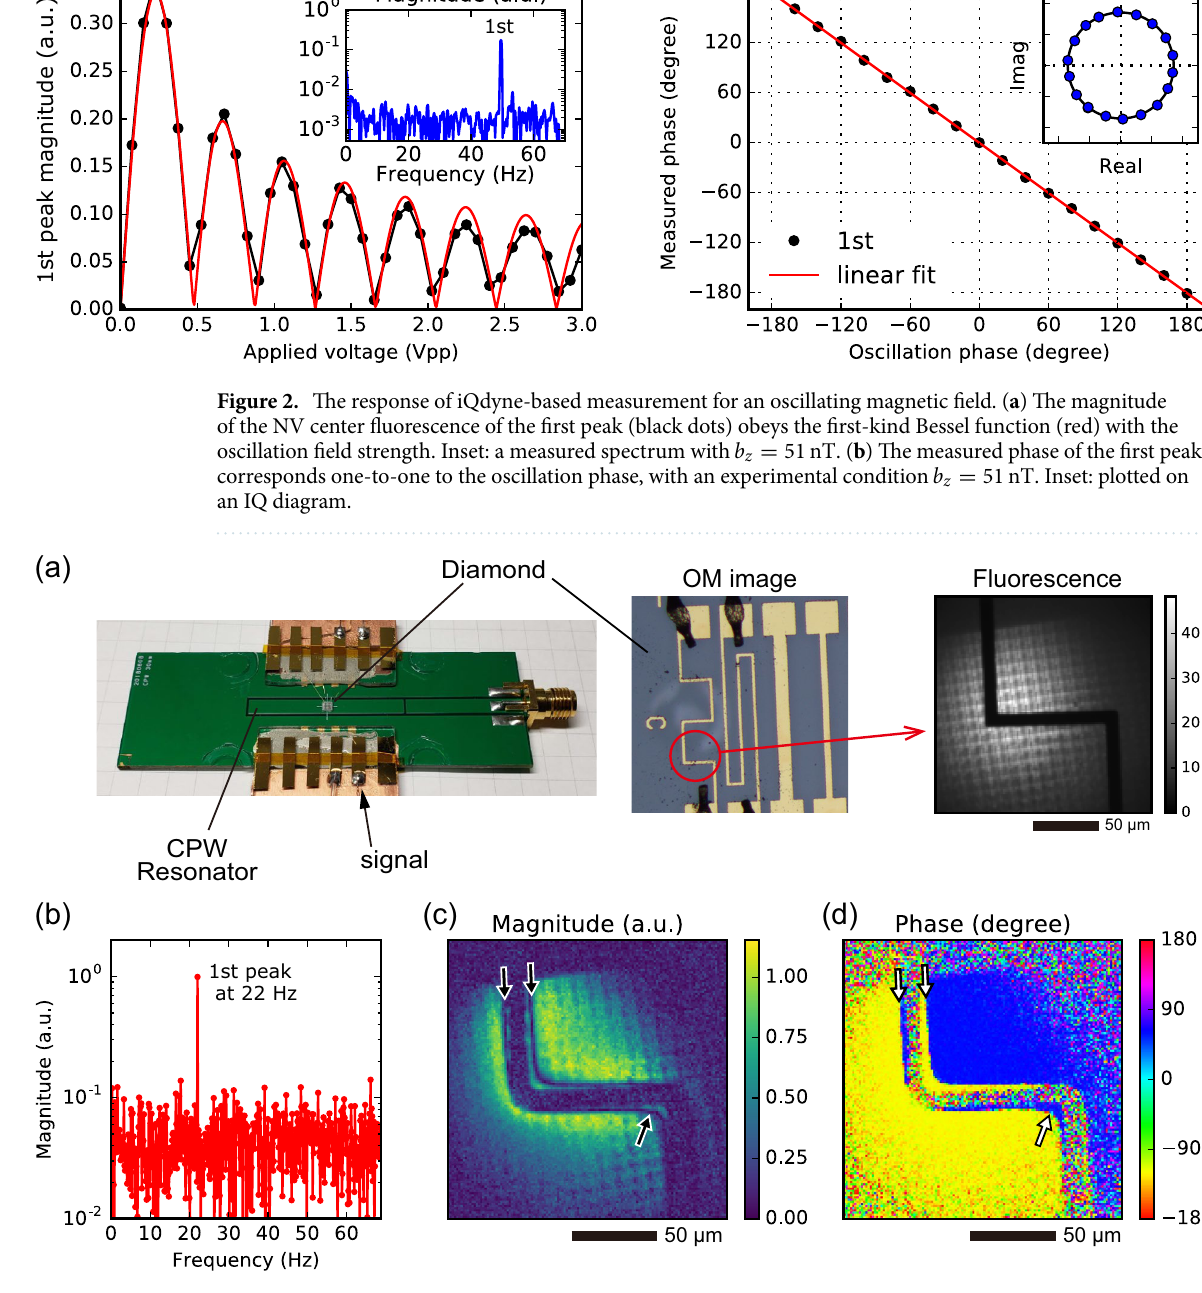
Figure 3. Simultaneous wide-field imaging experiment involving ( a ) the sample setup with the MW resonator to the left, the optical image of the current path as the signal source in the center, and fluorescence image to the right, ( b ) typical measured spectrum showing frequency versus magnitude, ( c ) the magnitude map, and ( d ) phase map of the first peak at each pixel. Arrows in ( c ) and ( d ) indicate zero-magnitude lines and phase inversion boundaries corresponding to the zero of Bessel